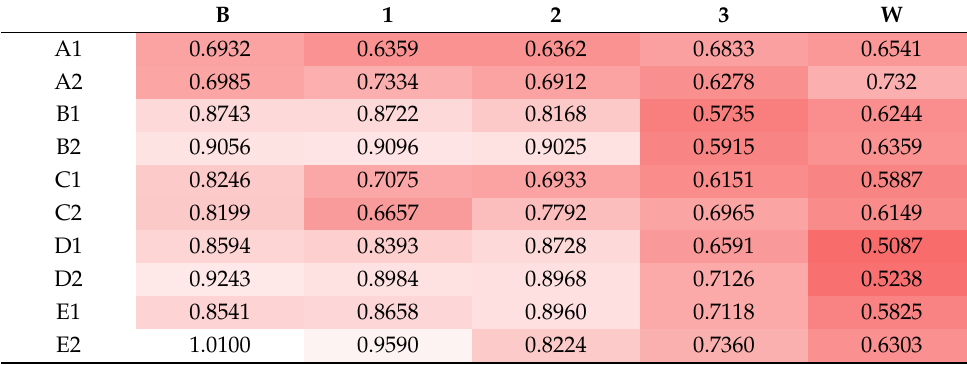
Table 5. Ratios between the real and simulated values of fitness function in the five robot locations for individual trajectories. Color gradient red–white is used for better visual representation of the value (white is the ideal ratio of 1.0, red is the ratio 0.5). B 1 2 3 W A1 0.6932